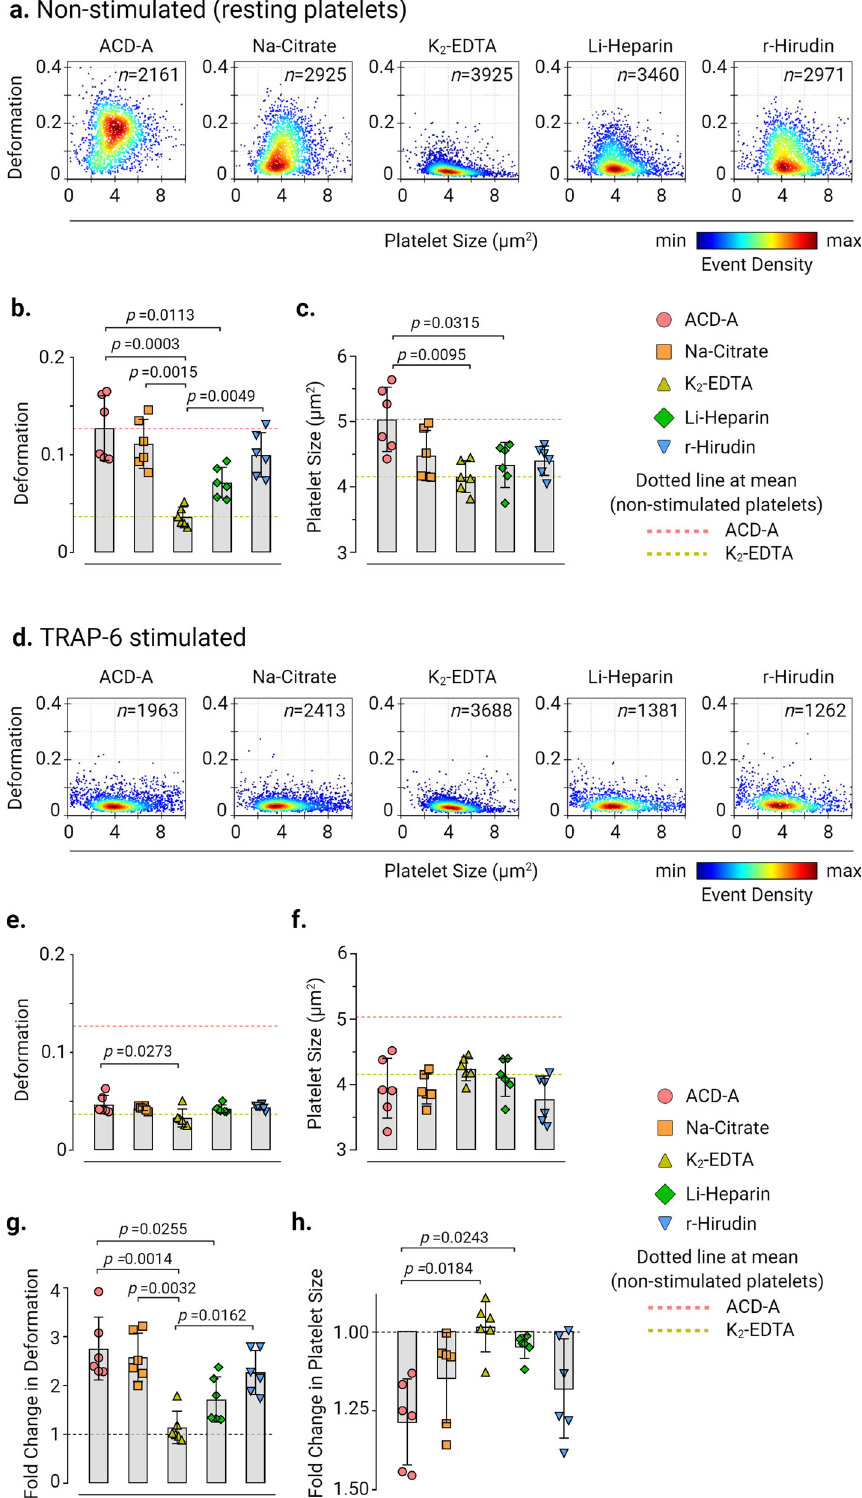
Fig. 1 Ex vivo anticoagulants in fl uence the deformation and size of human platelets. Representative KDE scatter plots of deformation and size of live single platelets in PRP prepared from whole blood collected in different ex vivo anticoagulants from a non-stimulated (i.e., resting) platelets and d after stimulation with TRAP-6 ( n = number of single platelets from the same donor measured for each condition). Color coding of event density in scatter plots indicates a linear density scale from min (blue) to max (dark red). Summary data points show the median values of individual donors, and bar plots show mean ± SD of platelet deformation and size from non-stimulated ( b ) and ( c ) and TRAP-6 stimulated platelets ( e ) and ( f ), respectively ( n = 6 donors). Fold change in platelet deformation and size upon stimulation with TRAP-6 are shown in ( g ) and ( h ), respectively, where dotted control baseline = 1 ( n = 6 donors). Statistical analysis: mixed-effects model (restricted maximum likelihood, REML) followed by Tukey ’ s multiple comparisons tests, with single pooled variance and p < 0.05 was considered signi fi